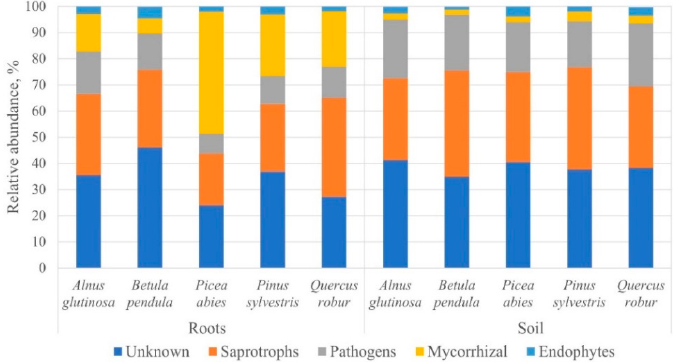
Figure 6. Ecological roles (shown as a proportion of the high-quality sequences) of the fungal and oomycete OTUs detected in the roots and soil of the different tree species. The data from the different forest nurseries are combined.